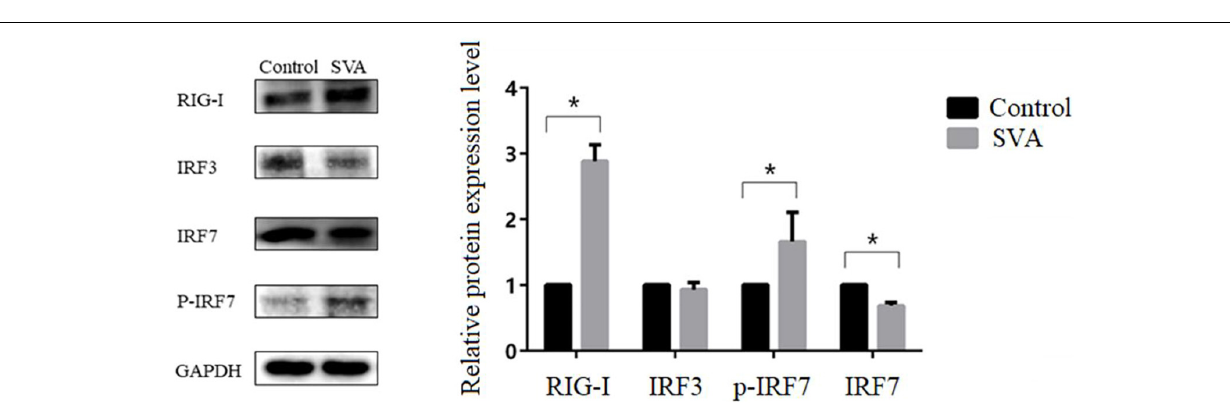
FIGURE 10 | Changes in the protein expression levels of RIG-I, IRF3, IRF7, and p-IRF7 in SVA-infected PK-15 cells. Western blotting was used to assess the expression levels of RIG-I, IRF3, IRF7, and p-IRF7 in the control group and PK-15 cells infected with SVA at an MOI of 2 for 24 h (* P <